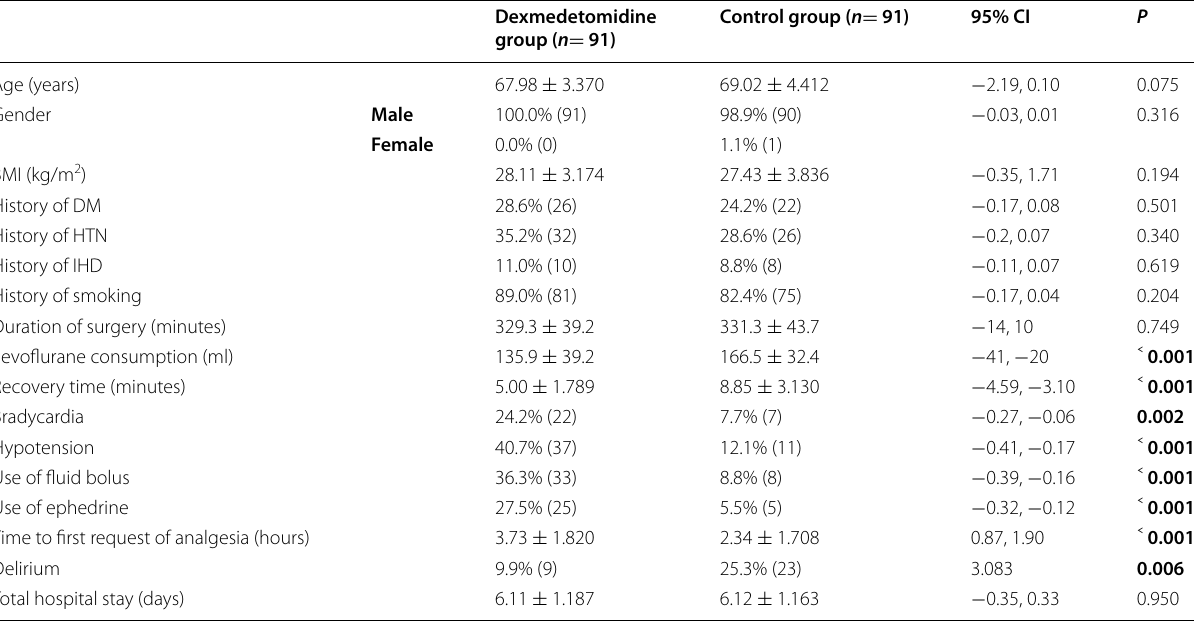
Table 1 Demographic characteristics, medical history, operative duration, sevoflurane consumption, recovery time, intra‑operative adverse events, first request of analgesia, incidence of delirium, and hospital